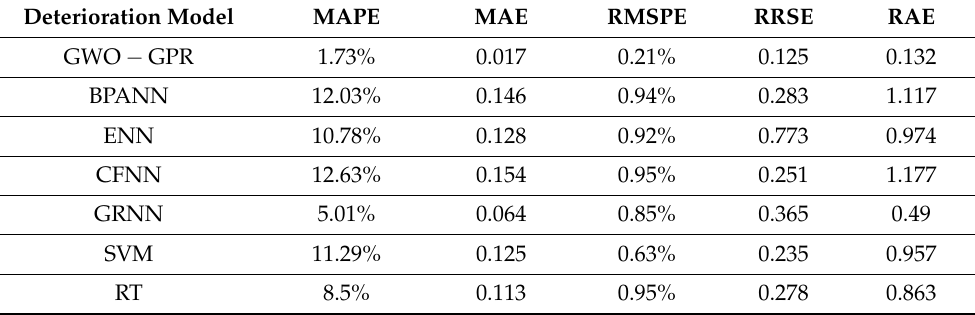
Table 5 records a forecasting performance comparison for the deterioration models of concrete portal. It is derived that the developed GWO − GPR model outperformed other deterioration models, whereas CFNN produced the highest prediction error. GWO − GPR resulted in an MAPE of 1.73%, MAE of 0.017, RMSPE of 0.21%, RRSE of 0.125, and RAE of 0.132. In addition, CFNN generated an MAPE of 12.63%, MAE of 0.154, RMSPE of 0.95%, RRSE of 0.251, and RAE of 1.177. The prediction performances for the deterioration models of concrete ceiling slab are listed in Table 6. It can be noticed that GWO − GPR model performed better than other deterioration models, and the models of BPANN and CFNN attained the lowest levels of prediction accuracies. GWO − GPR managed to induce an MAPE of 2.81%, MAE of 0.038, RMSPE of 0.88%, RRSE of 0.362, and RAE of 0.22. The performance evaluation results for the deterioration prediction models of concrete slab on grade are presented in Table 7. It can be observed that GWO − GPR yielded the lowest values of MAPE (1.21%), MAE (0.012), RMSPE (0.17%), RRSE (0.114), and RAE (0.138). Moreover, BPANN produced the highest values of of MAPE (16.22%), MAE (0.177), RMSPE (1.63%), RRSE (1.207), and RAE (2.016). Table 5. Performance comparison between deterioration prediction models of concrete portal. Deterioration Model